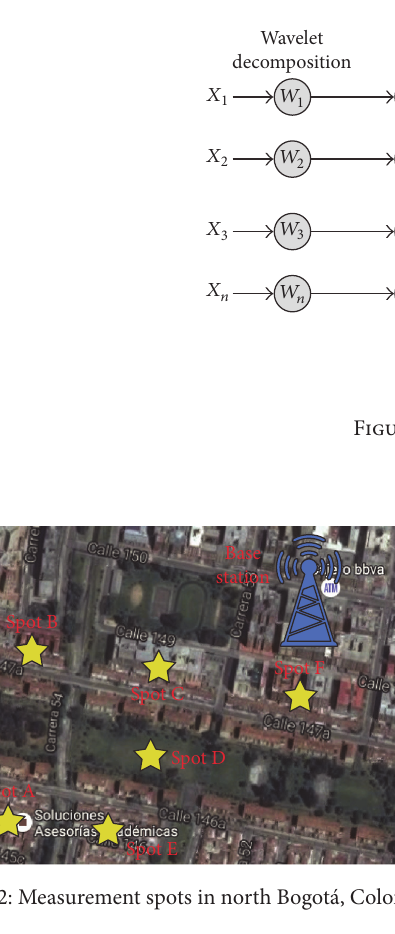
Figure 3: Theoretical and received power for the H-O model of the GSM